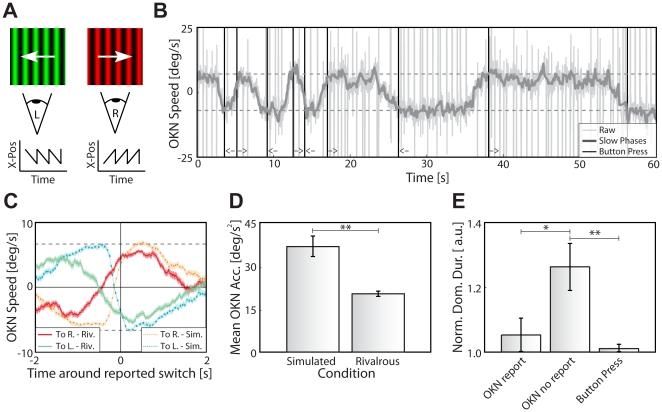
Experiment 3–OKN as a function of rivalry dynamics.(A) Example of binocular rivalry stimuli and OKN patterns. Rivalry and OKN were induced by presenting dissimilar gratings with opposite movement directions to each eye separately. (B) Example of the derivative of the horizontal eye position (OKN speed) as function of time during a single trial of one observer (dark grey). OKN's fast phases (light gray spikes) were removed and interpolated, and the resulting trace was smoothed. Black vertical lines indicate perceptual transitions; arrows denote movement direction of the dominant percept. Dashed grey horizontal lines at (-)6.67 deg/s indicate speed of the rivaling stimuli. The OKN speed of slow phases gradually increased and decreased as a function of time to transition. (C) Average OKN speed for rivalry transitions (green and red traces) and physical stimulus changes (simulated rivalry, orange and cyan traces), mean and s.e.m. across all dominance durations. OKN speed was more gradual during rivalry transitions as compared to physical changes of stimulus direction. (D) Average horizontal eye acceleration in a 0.2 time window around the OKN speed's zero crossing, mean and s.e.m. across observers for simulated (left) and real (right) rivalry. Acceleration during a perceptual transition, an indication of graduality of the OKN speed signal, was lower for rivalrous trials. (E) Normalized dominance durations per report conditions, mean and s.e.m. across observers. Dominance durations were normalized by dividing by the median dominance duration per observer. OKN-based dominance durations (default parameter settings) differ significantly in a condition when observers in addition report dominance by button press (left bar) as compared to trials without active report (middle bar). In the parameter regime, OKN-based dominance durations in the report condition do not differ from those based on subjective (button press) reports (right bar).